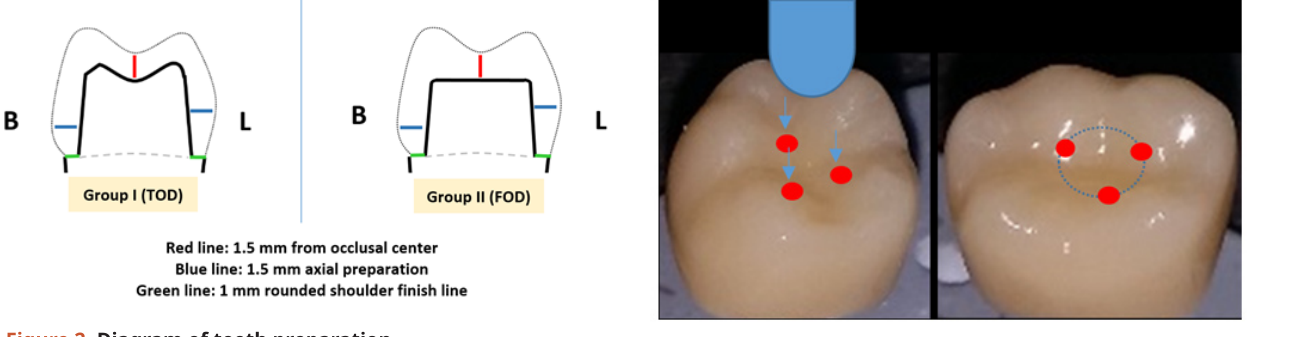
Figure 3. Three loading points on the inner inclines of the mesiobuccal, distobuccal and mesiolingual